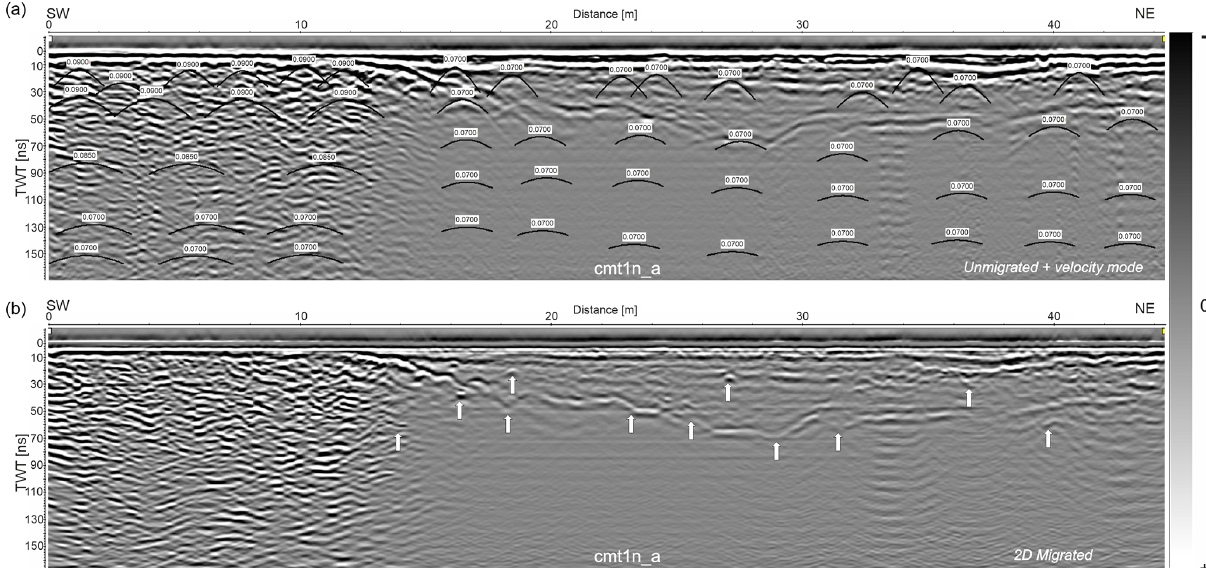
Figure 5. Example of 2D time-migration of radar profiles: (a) example of hyperbolic diffractions fitting used for 2D velocity model building; a constant velocity value (0.07mns − 1 ) was assumed in deeper no-diffraction areas for interpolation purposes; (b) 2D time-migration results, highlighting the good performance of the process, which collapsed the hyperbolic diffractions (white arrows) and restored reliable reflection